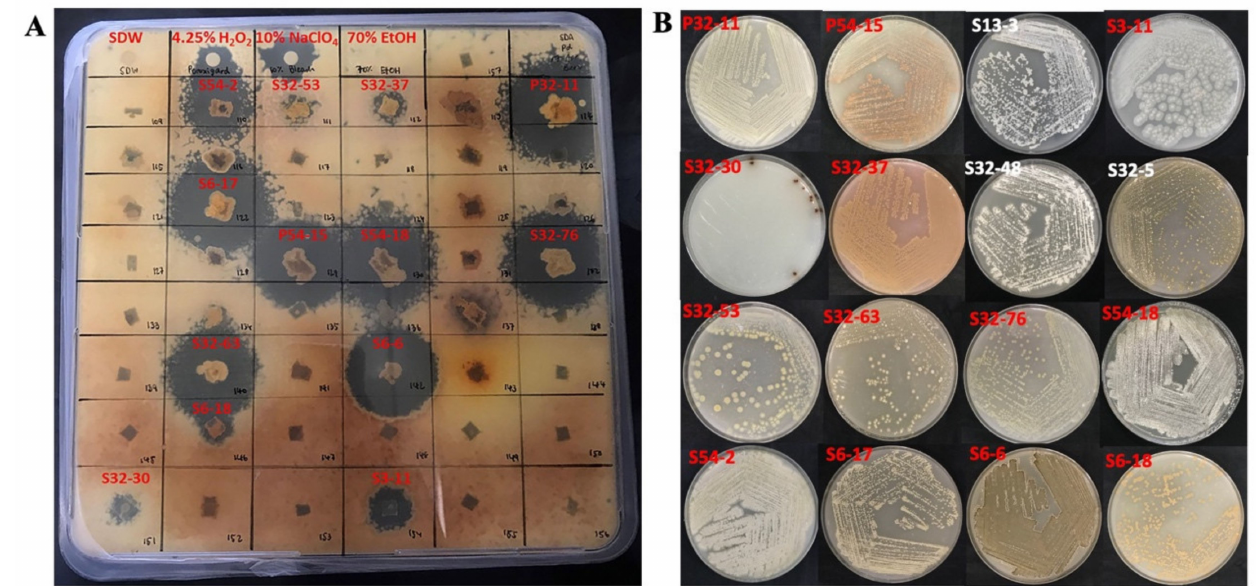
Figure 5. Representative strains that showed inhibition activity against P. destructans. ( A ) Anti- P. destructans activity of actinobacteria from mosses. ( B ) Colony morphological diversity of represen- tative actinobacteria that showed activities against diverse pathogens. Isolates were grown on an ISP3 medium for 2 weeks at 28 ◦ C. Letters in red indicate isolates with anti- P. destructans activity that also showed in ( A